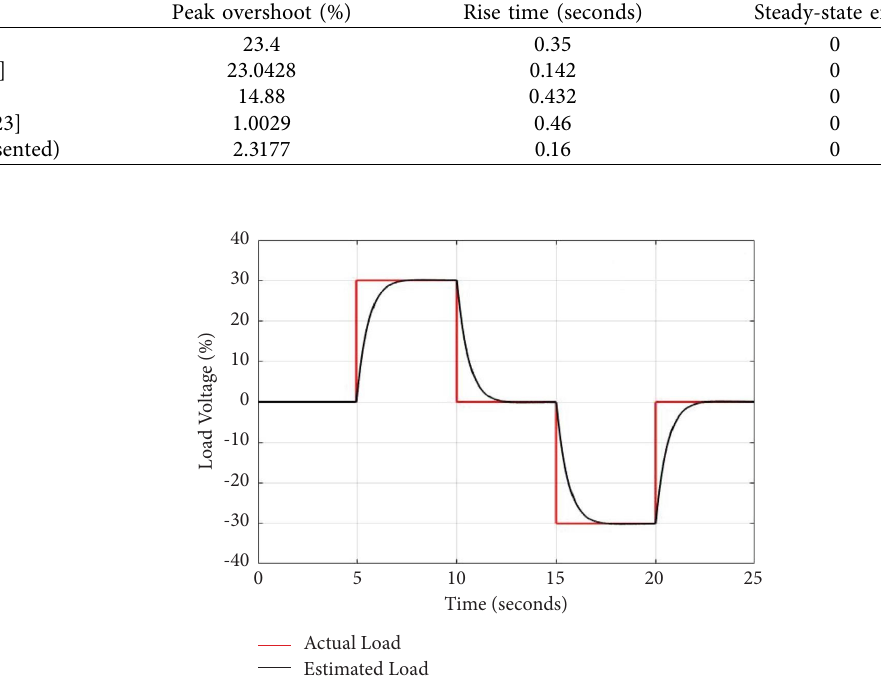
Figure 4: Estimation of ± 30% load voltage variation using MESOBC. Table 3: Dynamic response specifcation of AVR under ± 30% load voltage variation.